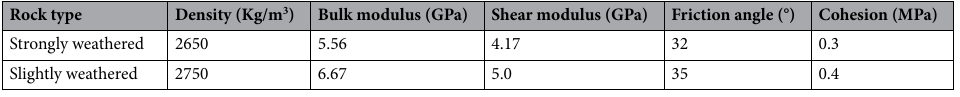
Table 2. Rock masses mechanical parameters of the slope.